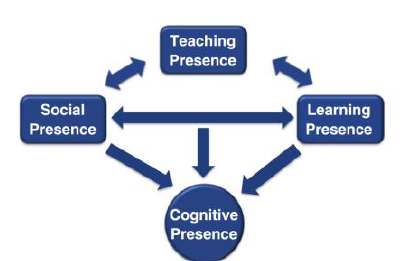
Figure 1. A revised CoI model (Source: Shea & Biderjano,